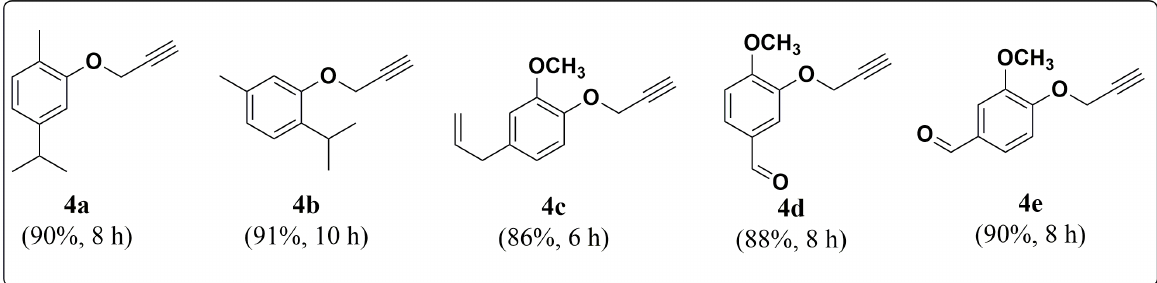
Figure 2. Synthesis of the alkynes terminal